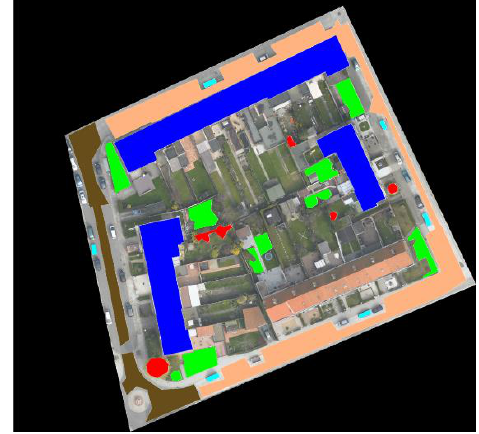
Figure 5. Manually observed sample data.